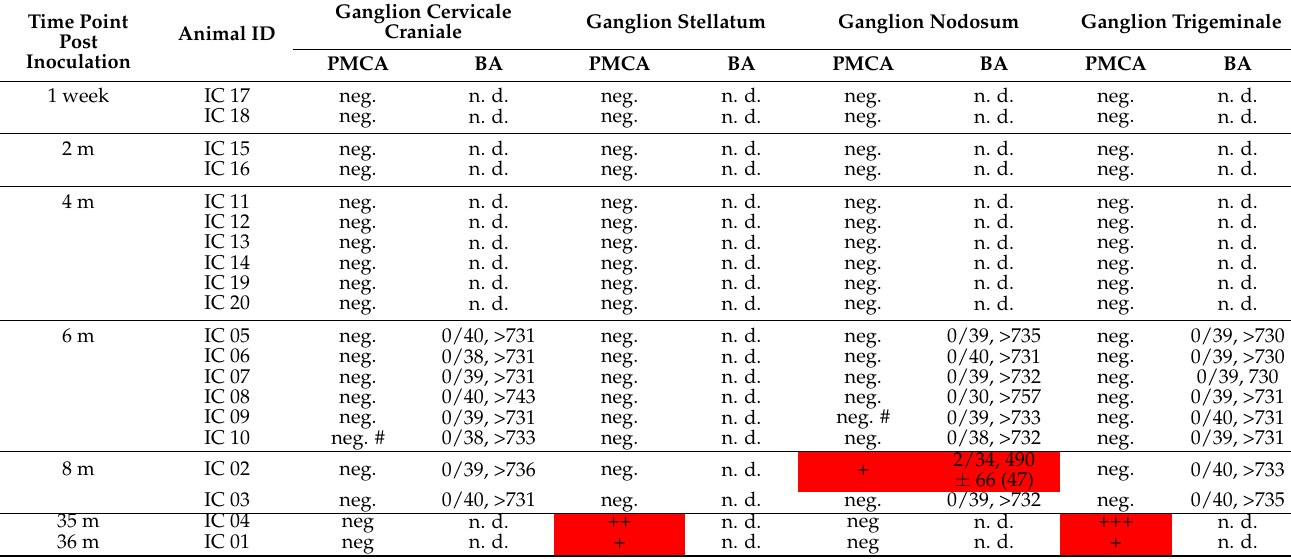
data, the titer of infectivity in the nodal ganglion was estimated to be 0.20 log10 TgBov mouse i.c. LD50/g (95% confidence interval: − 0.72–0.91). All other tissues that were sampled in the vicinity of the CNS of this animal and the second animal of this group (cranial cervical ganglion, stellate ganglion, trigeminal ganglion) were negative by IHC, PMCA as well as by transgenic mouse bioassay (Table 2). Table 2. Results for peripheral nervous tissues closer to the brain were achieved by PMCA and Tgbov XV mouse bioassay. Time Point Post Inoculation